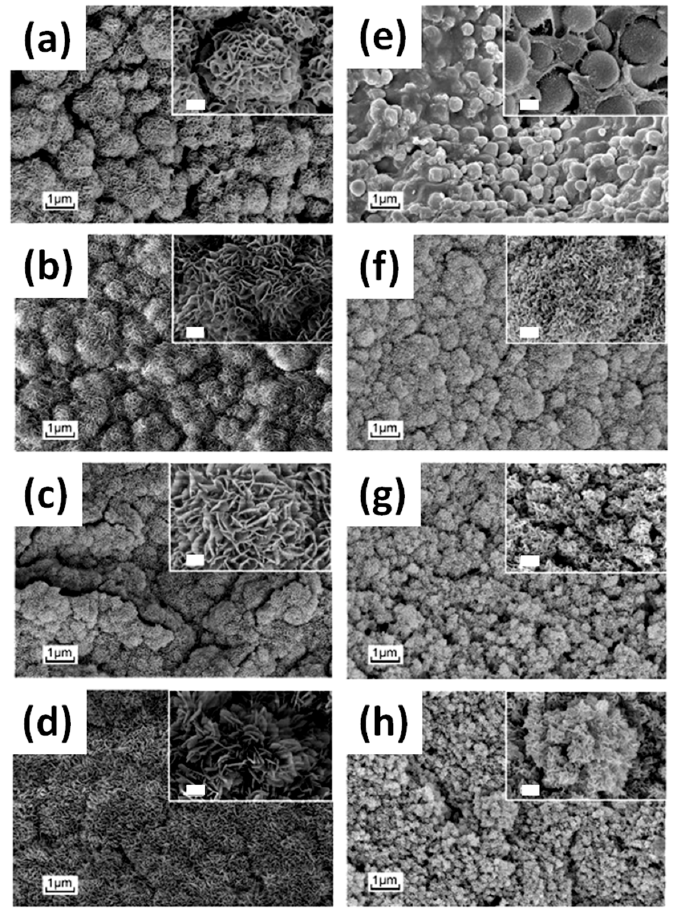
Figure 15. SEM images of the scaffolds after soaking in SBF, undoped scaffold: ( a ) 1 day; ( b ) 3 days; ( c ) 5 days; ( d ) 7 days; ZnO-doped scaffold: ( e ) 1 day; ( f ) 3 days; ( g ) 5 days; ( h ) 7 days. The insets are higher magnification (scale bar indicates 200 nm). Modified with permission from reference [103].